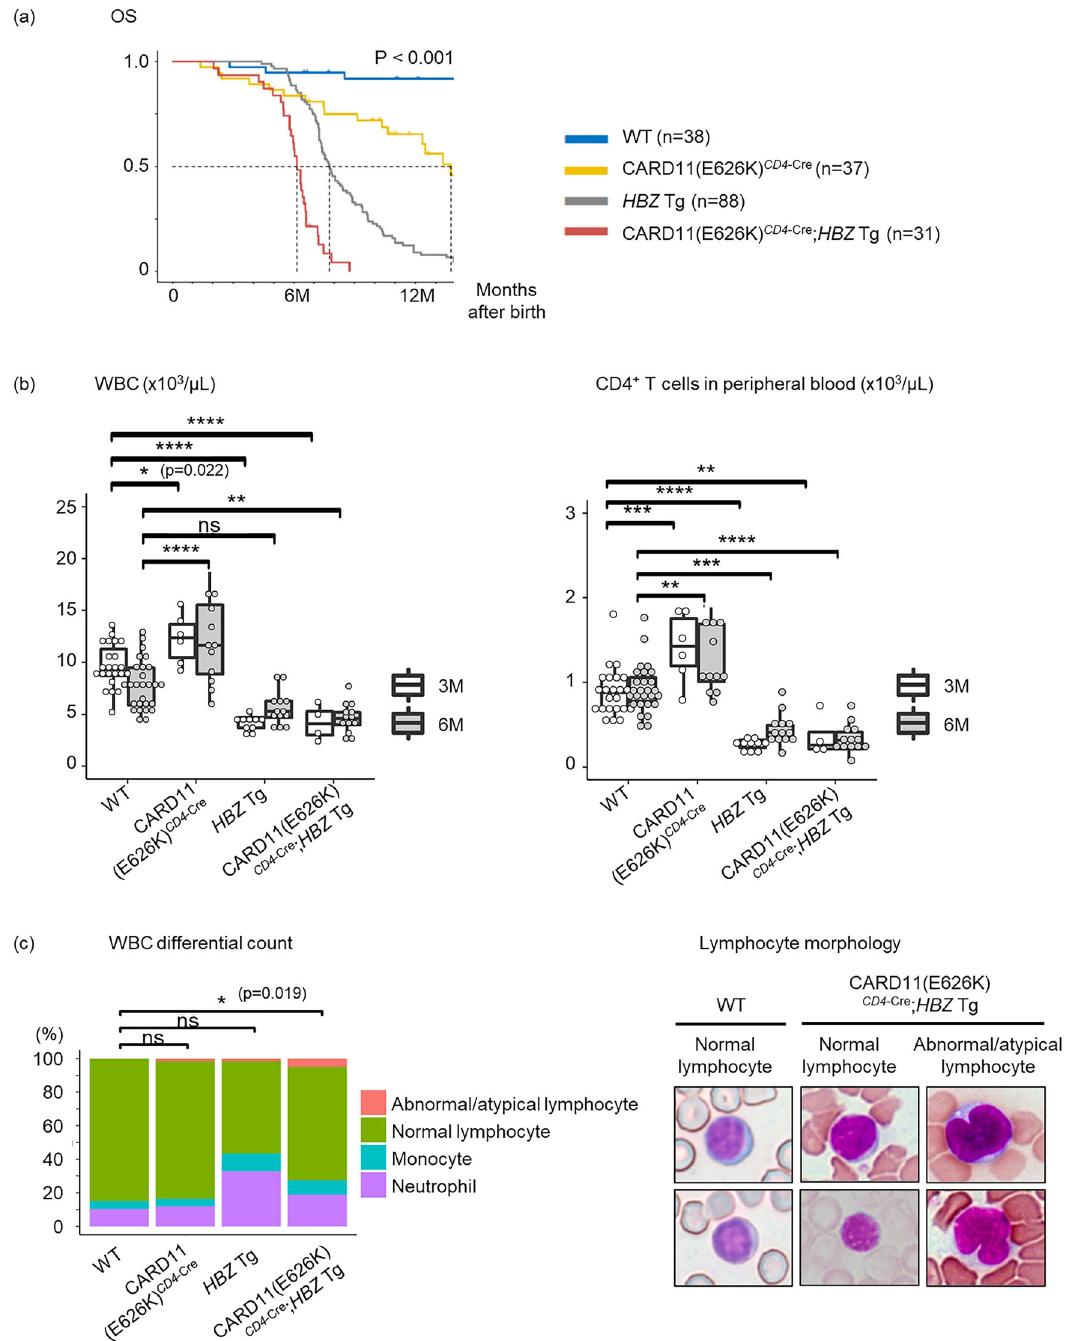
Fig. 1 Overall survival and cells in peripheral blood and spleen in WT, CARD11(E626K) CD4 -Cre , HBZ Tg, and CARD11(E626K) CD4 -Cre ; HBZ Tg mice. a Kaplan – Meier survival curves of mutant mice (wild type (WT), n = 38; CARD11(E626K) CD4 -Cre , n = 37; HBZ Tg, n = 88; CARD11(E626K) CD4 -Cre ; HBZ Tg, n = 31). The median survival times of WT, CARD11(E626K) CD4 -Cre , HBZ Tg, and CARD11(E626K) CD4 -Cre ; HBZ Tg mice, respectively, are as follows: not reached, 14, 8, and 6 months after birth. b The number of white blood cells and CD4 + T cells in peripheral blood in WT ( n = 23), CARD11(E626K) CD4- Cre ( n = 6), HBZ Tg ( n = 10), and CARD11(E626K) CD4 -Cre ; HBZ Tg ( n = 4) mice at 3 months after birth, and those in WT ( n = 27), CARD11(E626K) CD4 -Cre ( n = 12), HBZ Tg ( n = 13), and CARD11(E626K) CD4 -Cre ; HBZ Tg ( n = 13) mice at 6 months after birth. c The differential white blood cell count was performed manually, and a peripheral blood slide revealed that about 5% of lymphocytes in CARD11(E626K) CD4 -Cre ; HBZ Tg mice demonstrated pleomorphic nuclear features (WT, n = 5; CARD11(E626K) CD4 -Cre , n = 3; HBZ Tg, n = 3; CARD11(E626K) CD4 -Cre ; HBZ Tg, n = 3). The blood smear was stained with Wright-Giemsa. p values were calculated by the Tukey test after one-way ANOVA, and *, **, ***, and **** represent p values less than 0.05, 0.01, 0.001, and 0.0001,